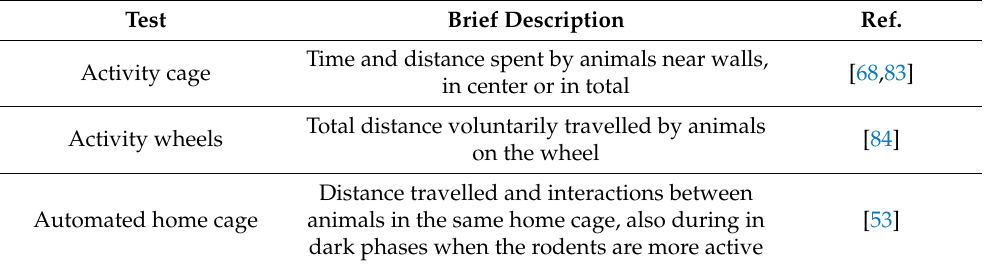
Table 3. Locomotor activity